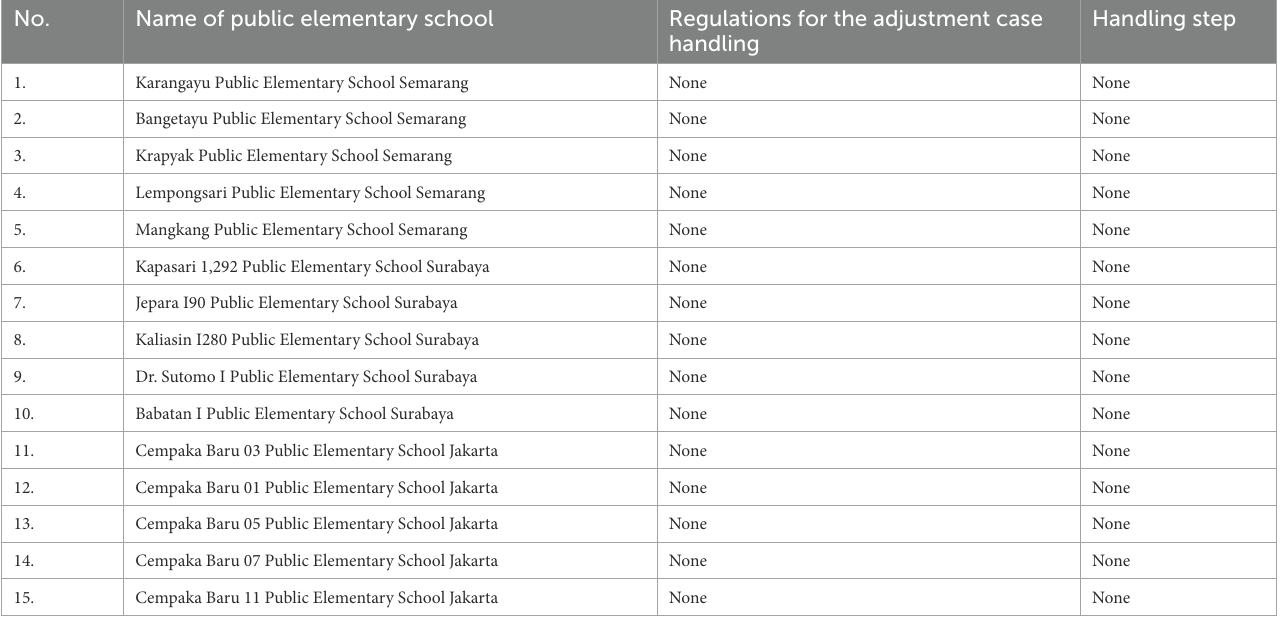
TABLE 4 Student neglect in school